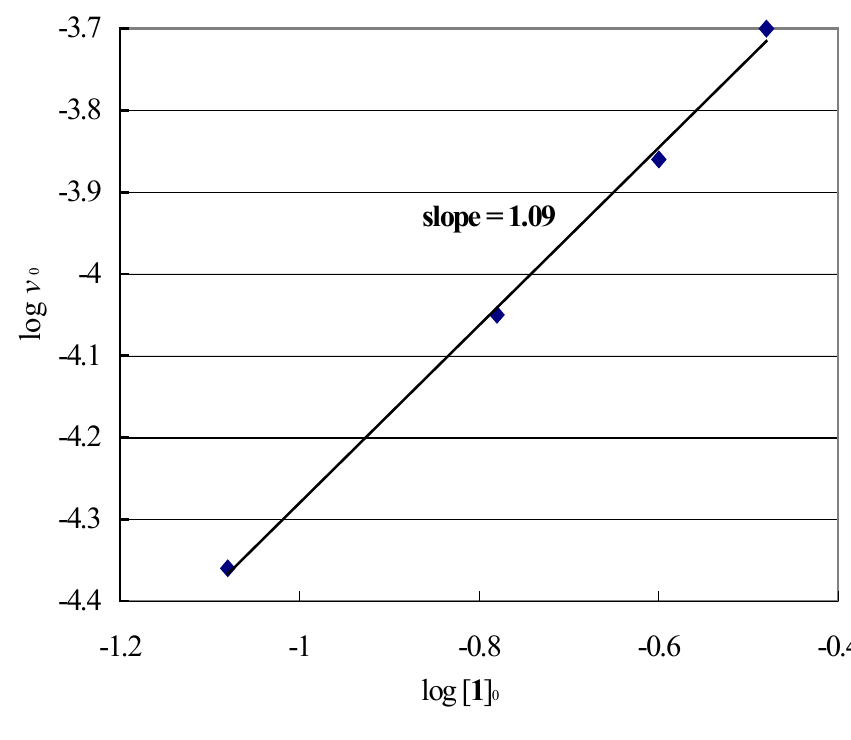
Figure 1 . The logarithms of initial rates ( υ of 2- and 4-(methylthio)phenyl phenyl sulfides 5 are plotted against the logarithms of the initial concentration [ 1 ] thioanisole ( 4 ) (12.0 mL) in the presence of TFA (8.0 mL) and CH at 10 ° C